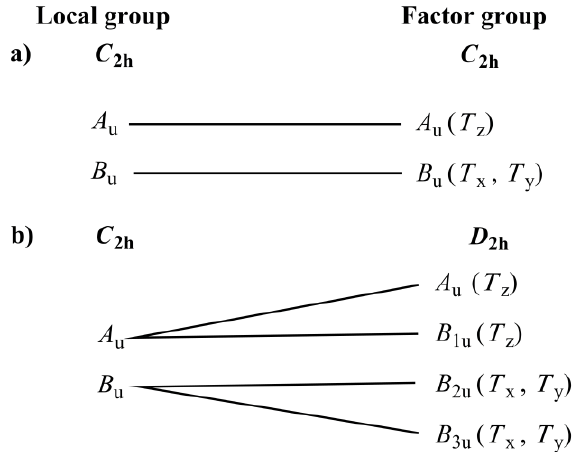
Figure 5. Correlation diagrams of silver in ( a ) monoclinic ( 1-M ) and ( b ) orthorhombic ( 1-O ) poly- morphs of [Ag(NH 3 ) 2 ]ClO 4 . morphs of [Ag(NH 3 ) 2 ]ClO 4